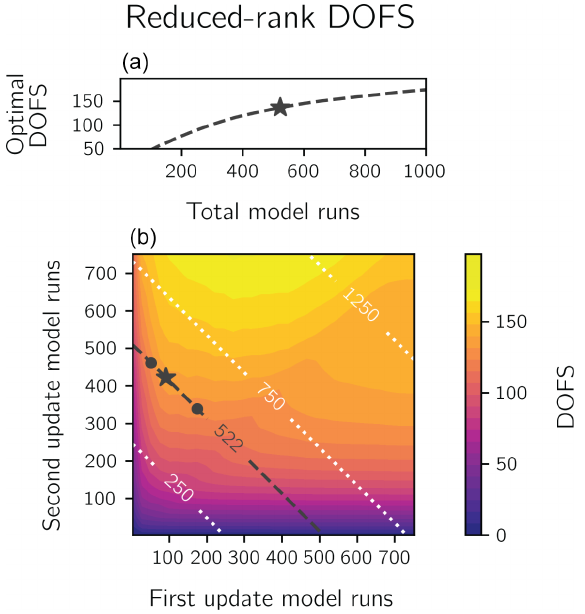
Figure 4. The sensitivity of the reduced-rank inversion DOFS to the number of forward model runs. Panel (b) shows the sensitivity of the DOFS to the partitioning of model runs between the first ( x axis) and second ( y axis) update. The lines represent the total number of simulations. Our inversion uses a signal-to-noise ratio of 1.25 for the first update and an information content threshold of 97% for the second update (star), requiring 522 forward model runs and generating 137 DOFS, accounting for 69% of the native-resolution DOFS at a quarter of the computational expense. Using a signal- to-noise ratio of 0.75 or 1.75 with the same total number of model simulations (dots) does not substantially decrease the DOFS. Panel (a) shows the DOFS as a function of the total number of model runs for all optimal first- and second-update